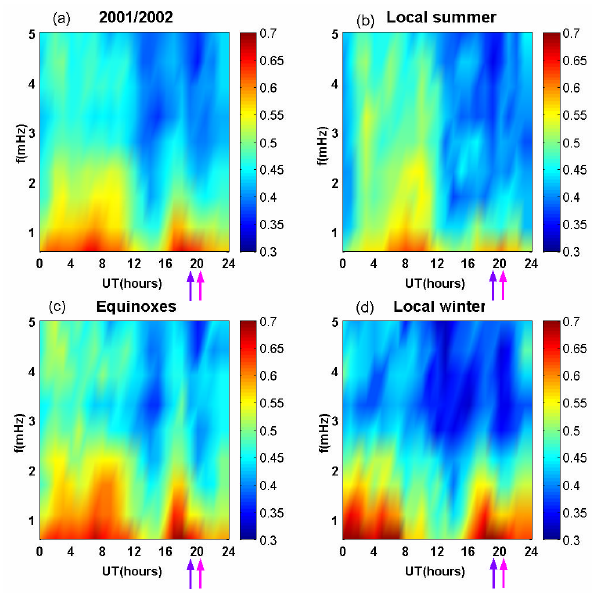
Fig. 2. Daily distribution of the average coherence between fluc- Figure 2 tuations at TNB and SBA for: (a) the whole 2-years interval, (b) local summer, (c) equinoxes, (d) local winter. Pink and violet ar- rows in all the plots indicate local geomagnetic noon at TNB and SBA, respectively.